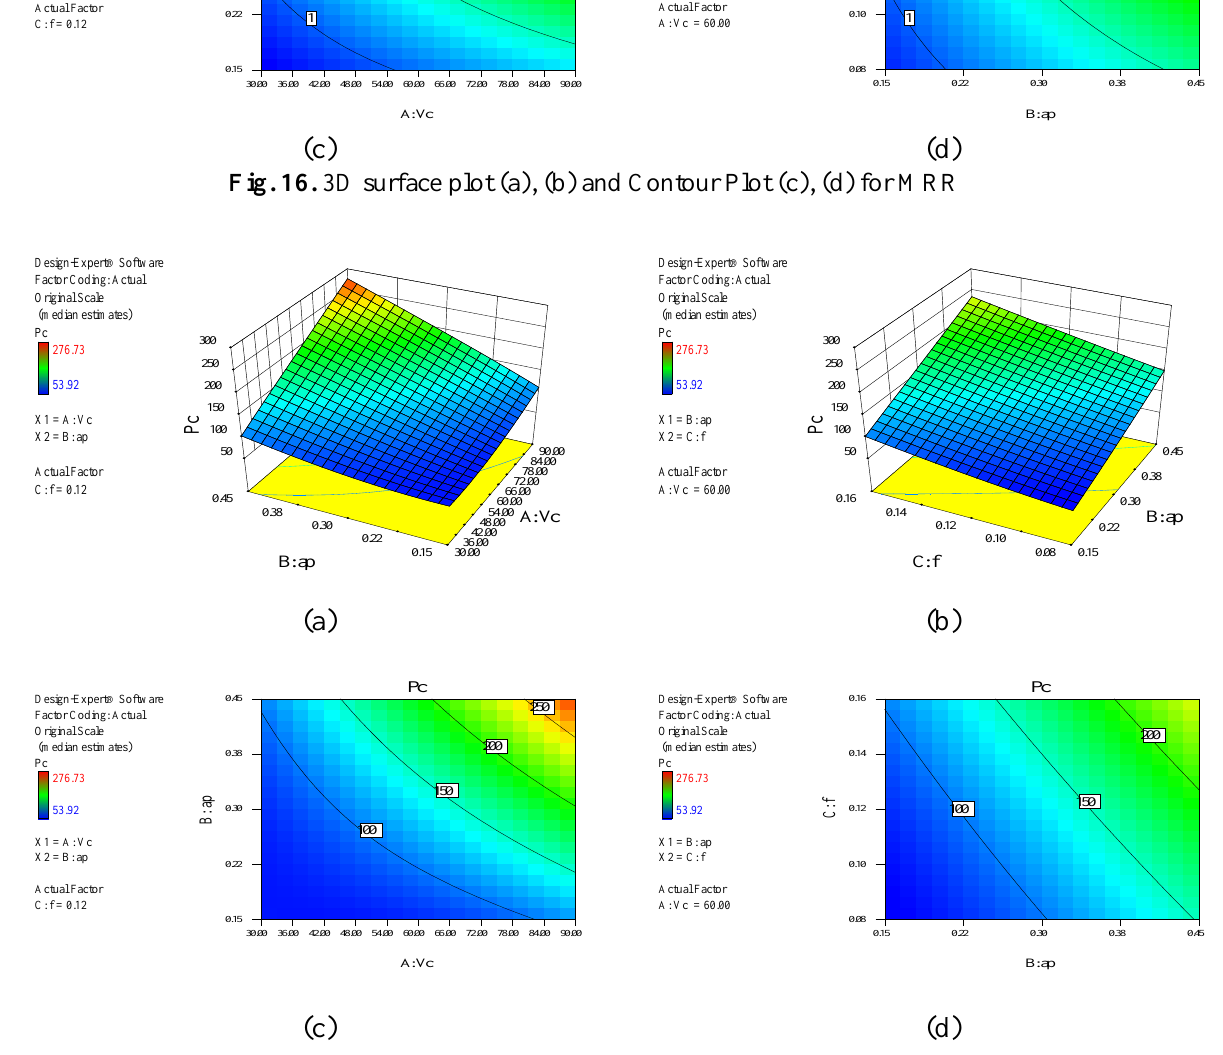
Fig. 17. 3D surface plot (a), (b) and Contour Plot (c), (d) for